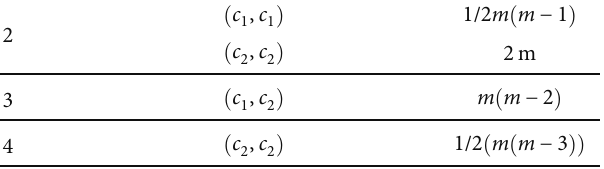
Figure 2: Jahangir graph J